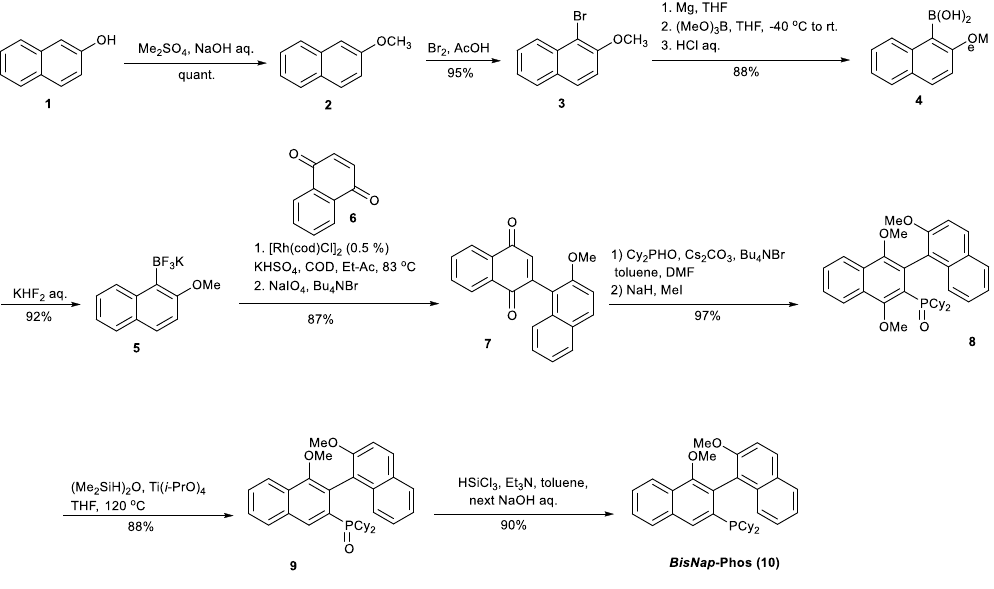
Figure 1. Highly efficient C,P-ligands and selected chiral ligands.